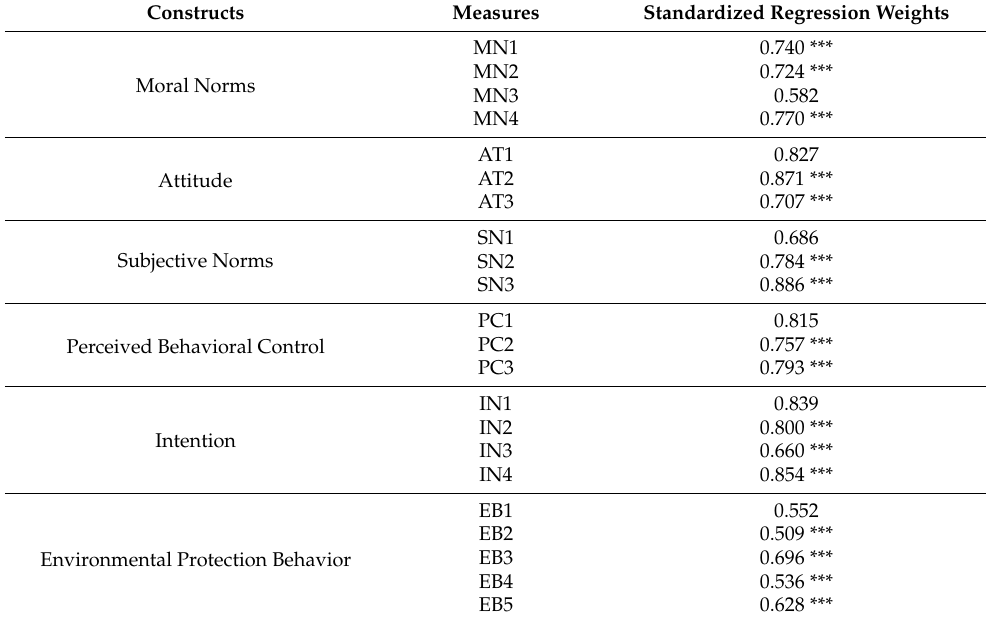
Table 5. Results of confirmatory factor analysis for Model